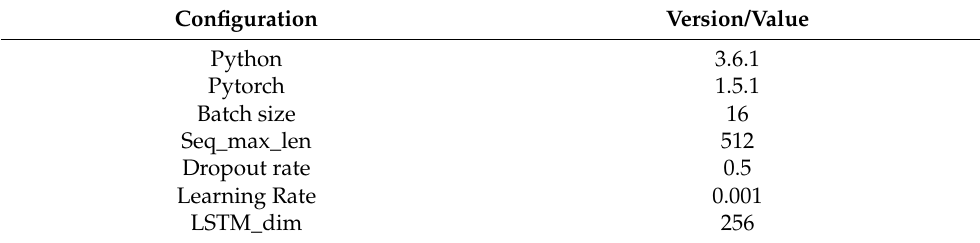
Table 2. Experimental environment and parameter